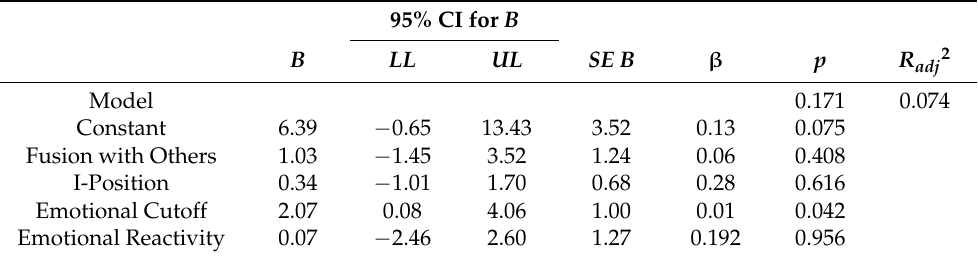
Table 8. Differentiation of self-inventory-short form as a predictor for psychological adjustment to separation test co-parenting conflict